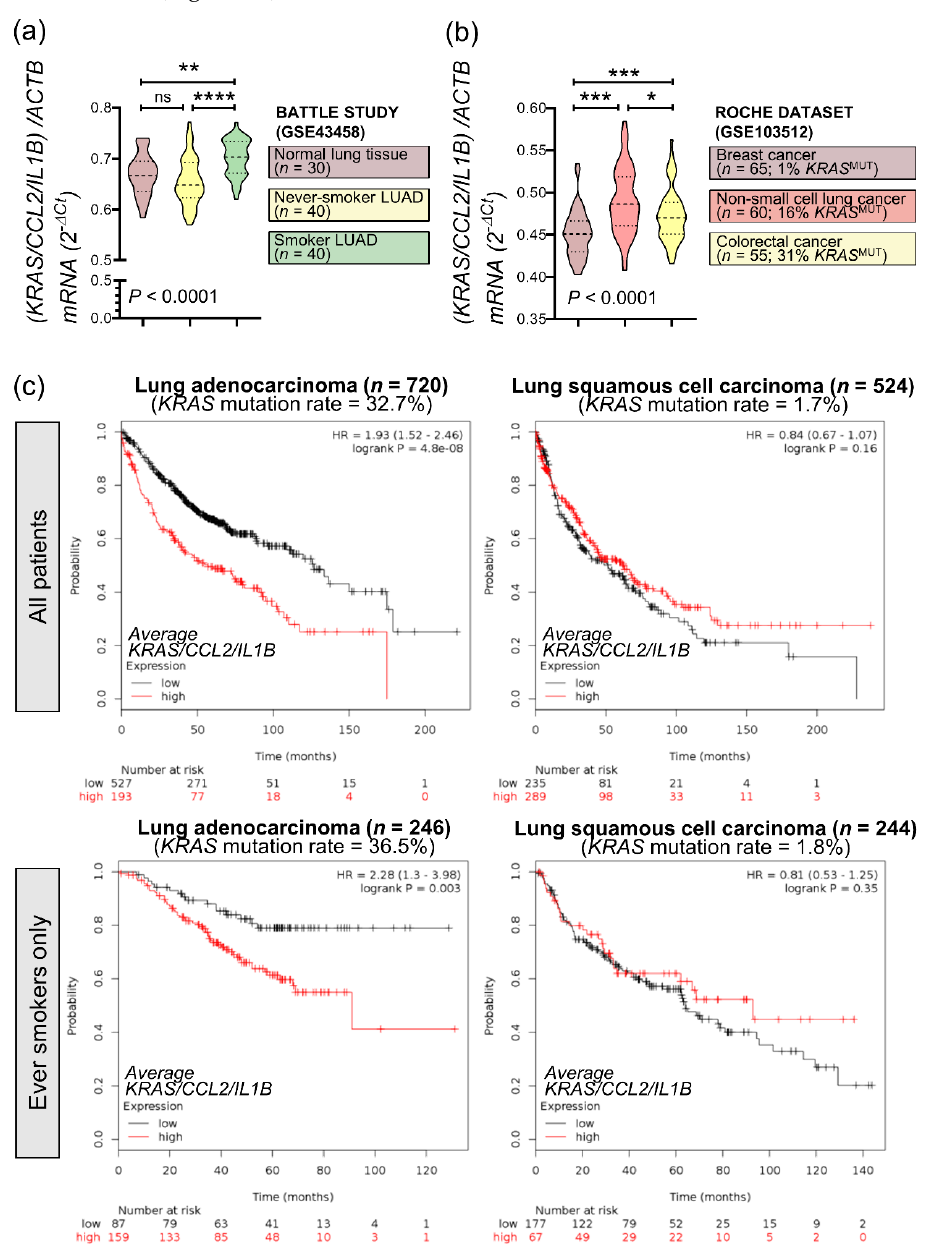
Figure 7. Mean expression of KRAS/CCL2/IL1B is increased in KRAS -mutant cancers and predicts poor survival. ( a ) Average KRAS/CCL2/IL1B expression normalized to ACTB in lung adenocarcinomas (LUAD) from smokers and never-smokers and normal lung tissue from never-smokers from the BATTLE study (GSE43458) [25,26]. ( b ) KRAS/CCL2/IL1B expression normalized to ACTB in breast, non-small cell lung, and colorectal cancer (ROCHE study GSE103512). KRAS mutation frequencies of these tumor types are from COSMIC [4]. ( c ) Kaplan-Meier analyses of lung cancer patients stratified by average KRAS/CCL2/IL1B expression performed using http://www.kmplot.com, accessed on 15 October 2021 [21]. KRAS mutation frequencies are from the Campbell cohort [27]. Top: all patients; Bottom: ever-smokers only. ( a , b ) Data are presented as violin plots. p , overall probability according to one-way ANOVA. ns, *, **, and ***: p > 0.05, p < 0.05, p < 0.01, and p < 0.001, respectively, for the indicated comparisons via Bonferroni post-tests. ACTB ,